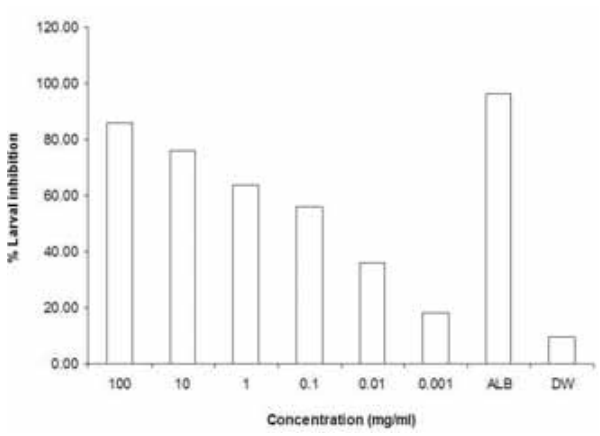
Figure-3: Effect of different concentrations of crude Figure-4: Effect of different concentrations of crude methanol extract of on the Cassia occidentalis in vitro methanol extract of on the Guiera senegalensis in vitro development of larvae. H. contortus development of larvae. H. defined by y = 5.79x + 62.54 and y = 3.43x + 72.94, in vitro and in vivo in vitro